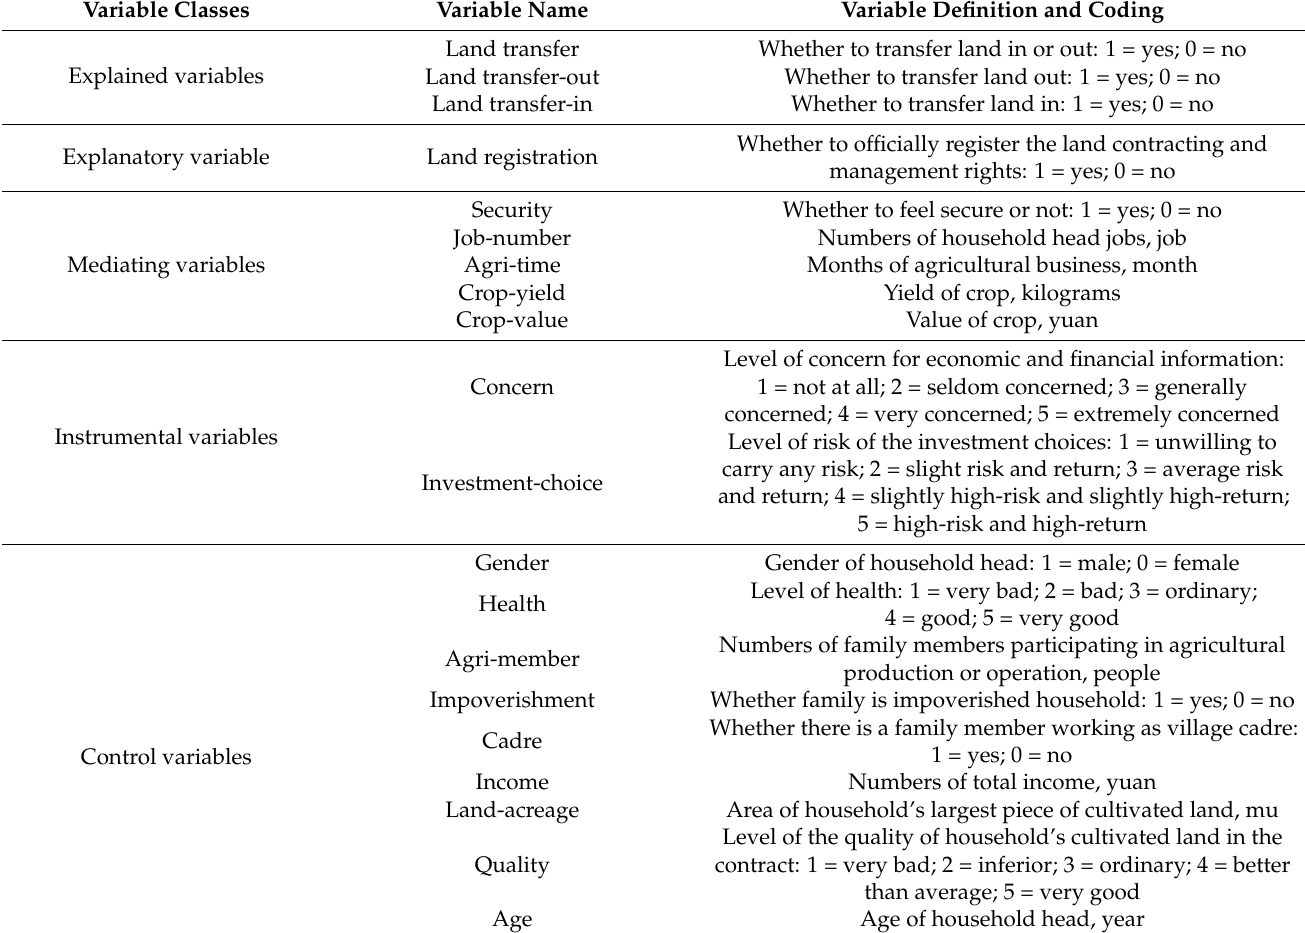
Table 2. Variables definition and